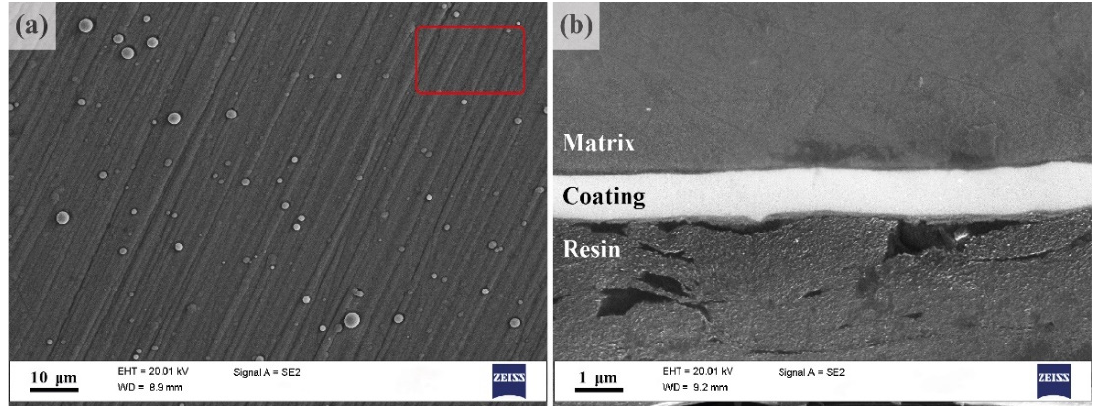
Figure 5. SEM images illustrating the Zr coating appearance of the specimen surface ( a ), and a view of the cross-section of the coating deposited on the ZK60 substrate ( b ); the area for the EDS spectroscopy analysis is indicated by a red rectangle (shown for the coating only).